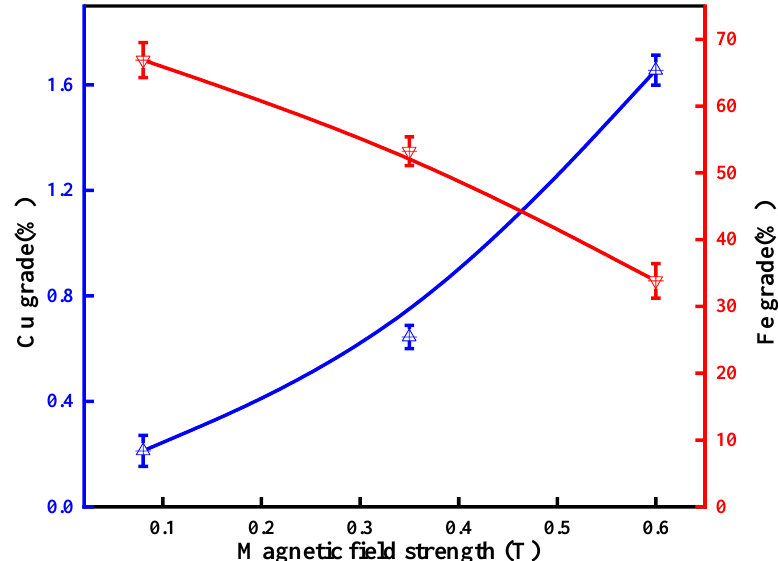
Figure 9. Influence of magnetic field strength on COBL ore during magnetic separation.